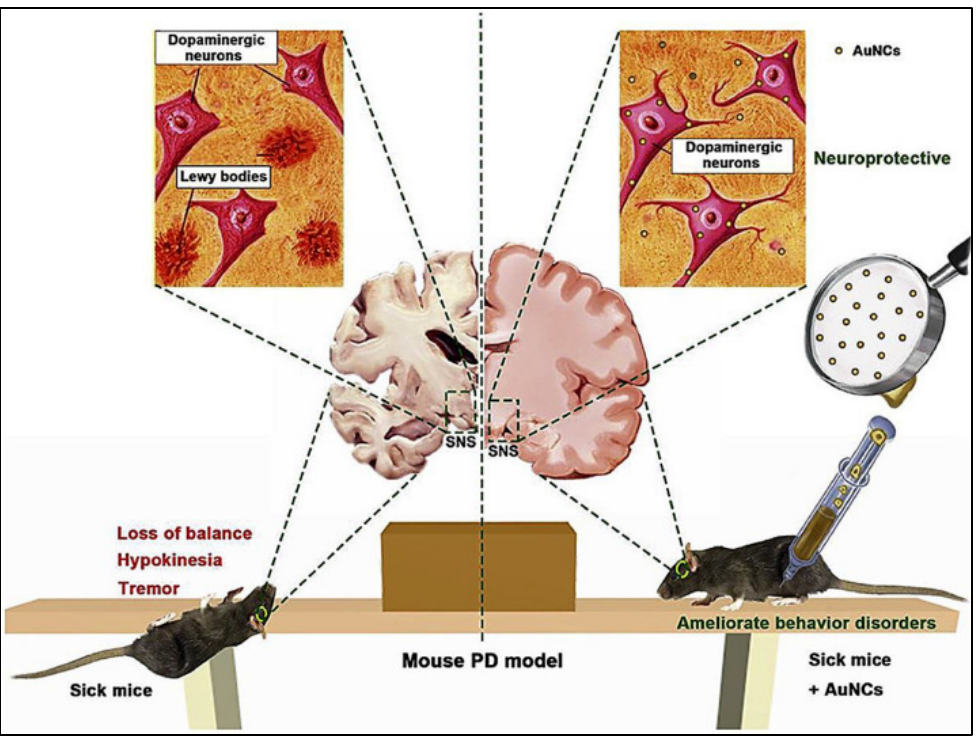
Figure 3. Schematic diagram of the possible mechanisms for the treatment of PD. Adopted from [111]. Copyright Elsevier 2021.